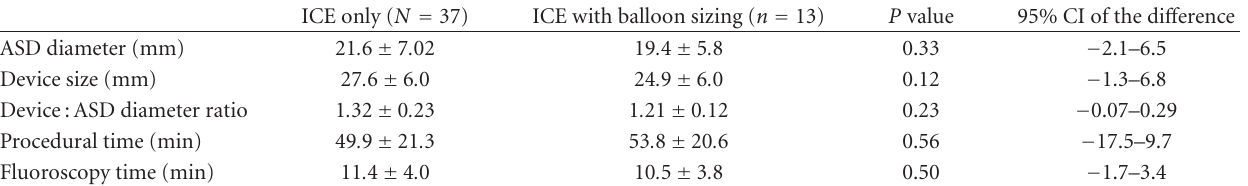
Table 5: Comparison of ASD diameters, device sizes, device ratios, and procedural times in successful cases of patients who had ICE only or ICE with balloon sizing.